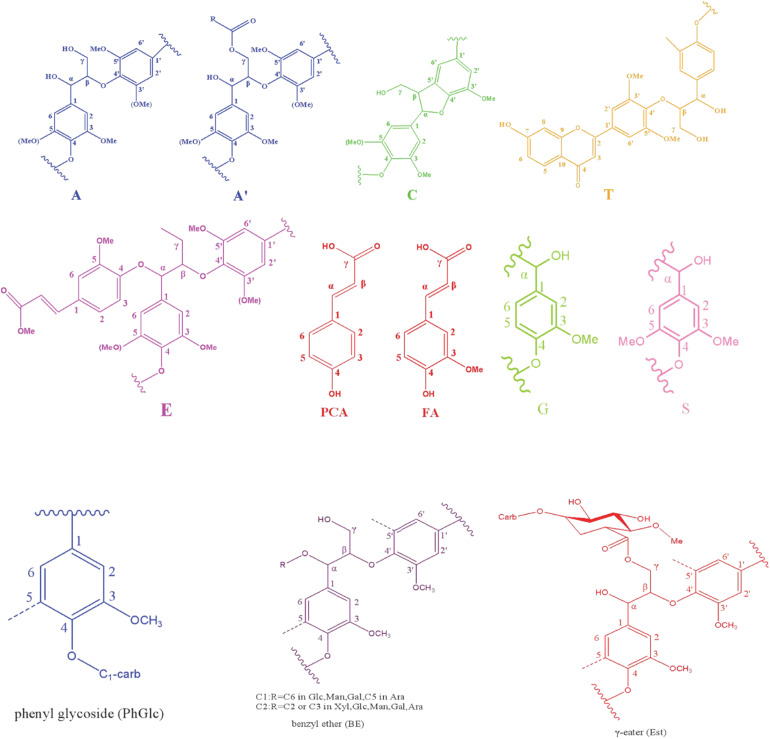
Main structures identified in the LCC preparations.